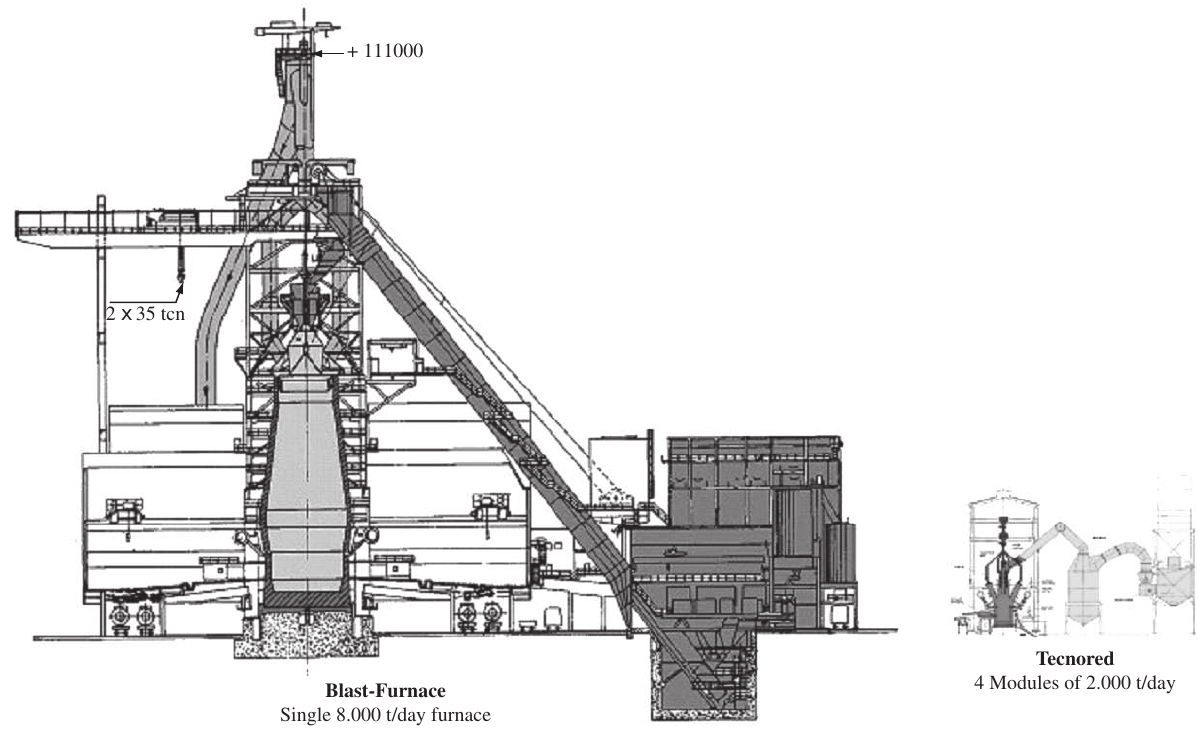
Figure 4. Elevation of a conventional blast furnace and a Tecnored furnace.